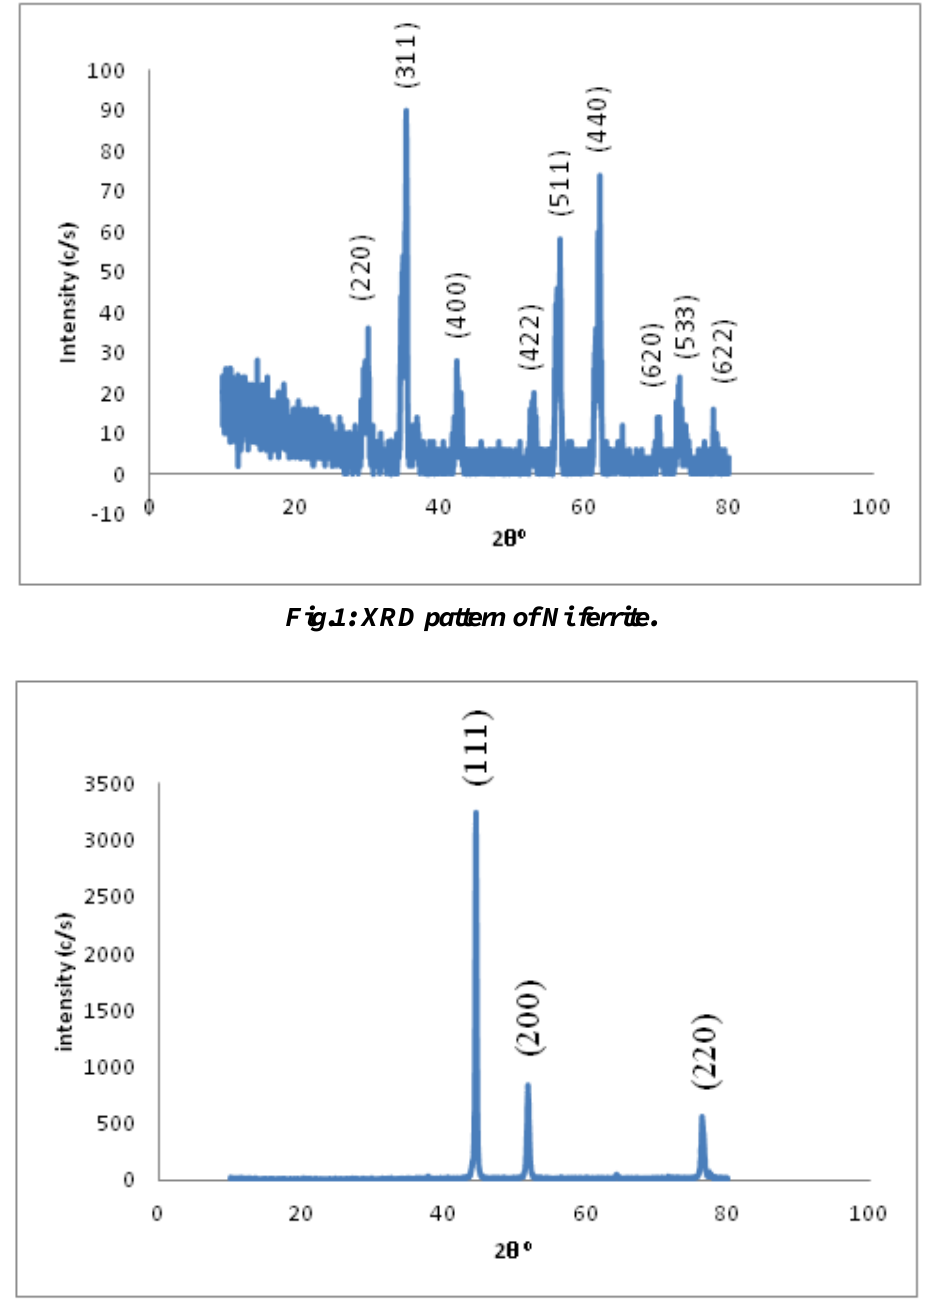
Fig.2: XRD pattern of Ni